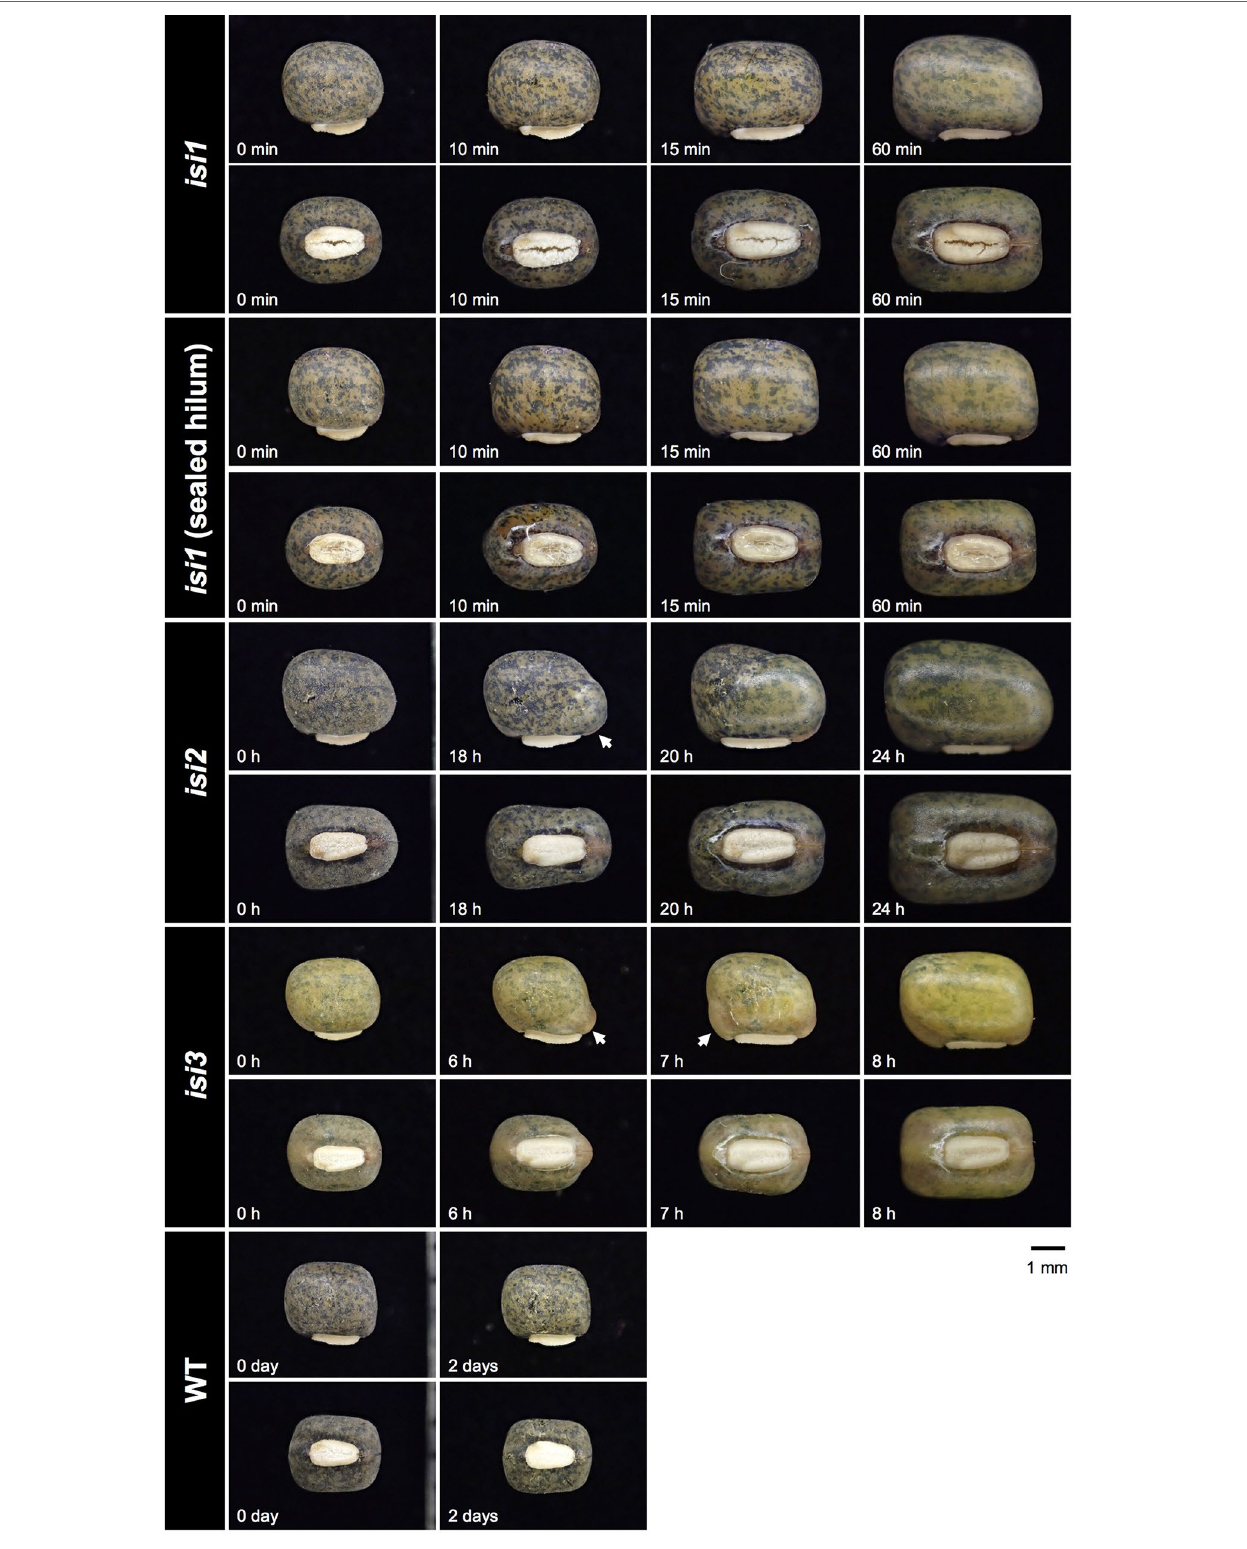
FIgURe 5 | Increased seed imbibition mutants of V. stipulacea. Time after watering is indicated at the bottom-left of each photo. Arrows indicate where water entry was initiated.